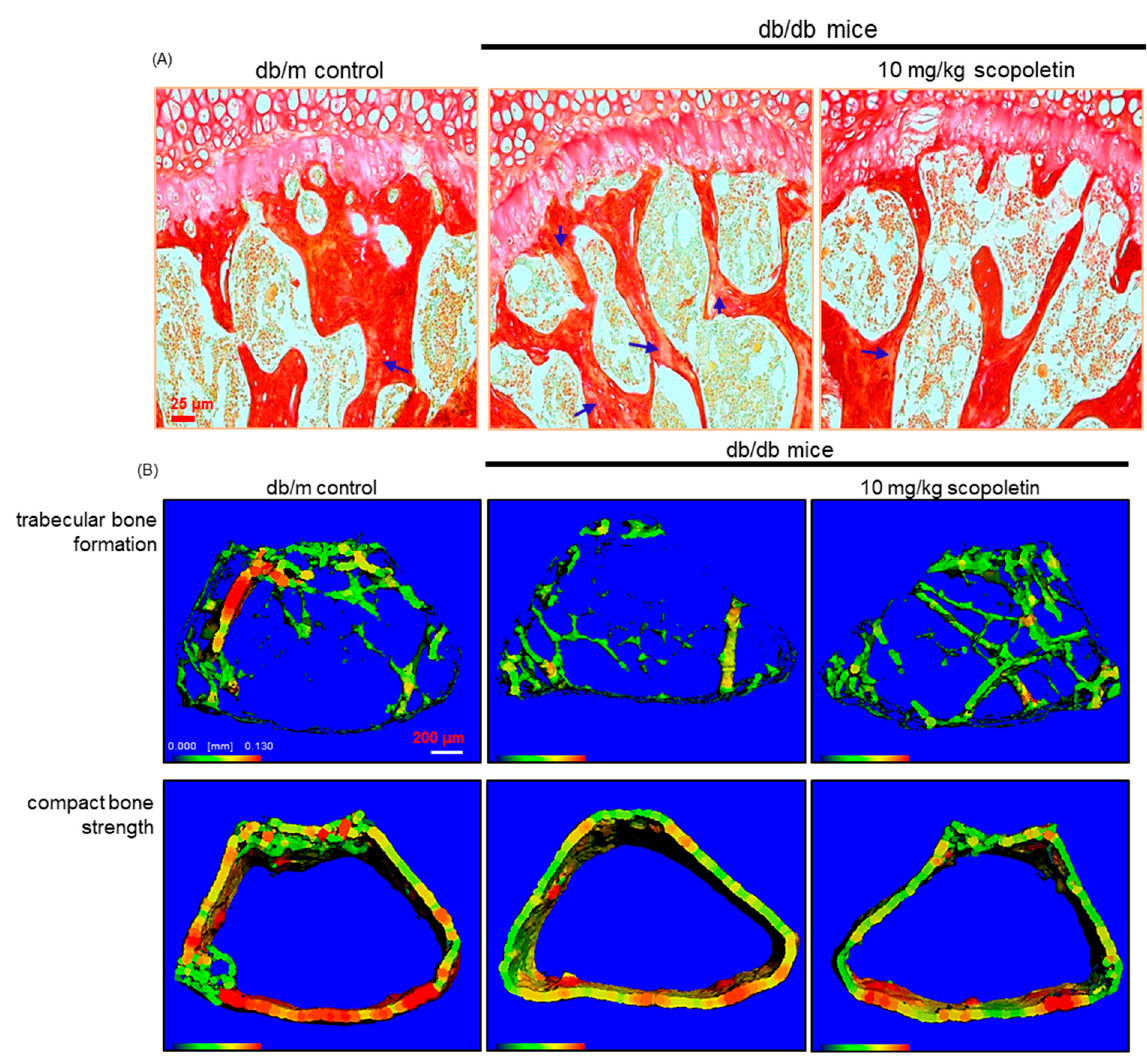
Figure 5. Formation of trabecular collagen fibers ( A ), and micro-computed tomographic (micro-CT) images ( B ) of femoral bone tissues in db/db mice. The db/db mice were orally administrated with 10 mg/kg scopoletin daily for 10 weeks. Picrosirius red staining was conducted for detecting trabecular bone collagen ( A ). The arrows indicate the depletion of collagen fibers in trabecular bones of the epiphysis. Representative images were visualized under light microscopy. Scale bar = 25 μ m. Three-dimensional trabecular bone and compact bone are shown by micro-CT reconstruction at the distal femurs ( B ). For the 3D images analysis, 1150 slices with a voxel size of 7 μ m were scanned in regions from the distal femur to tibia, and 100 slices were selected. Scale bar = 200 μ m. Table 2. Osteogenic activity of scopoletin in db/db mice.